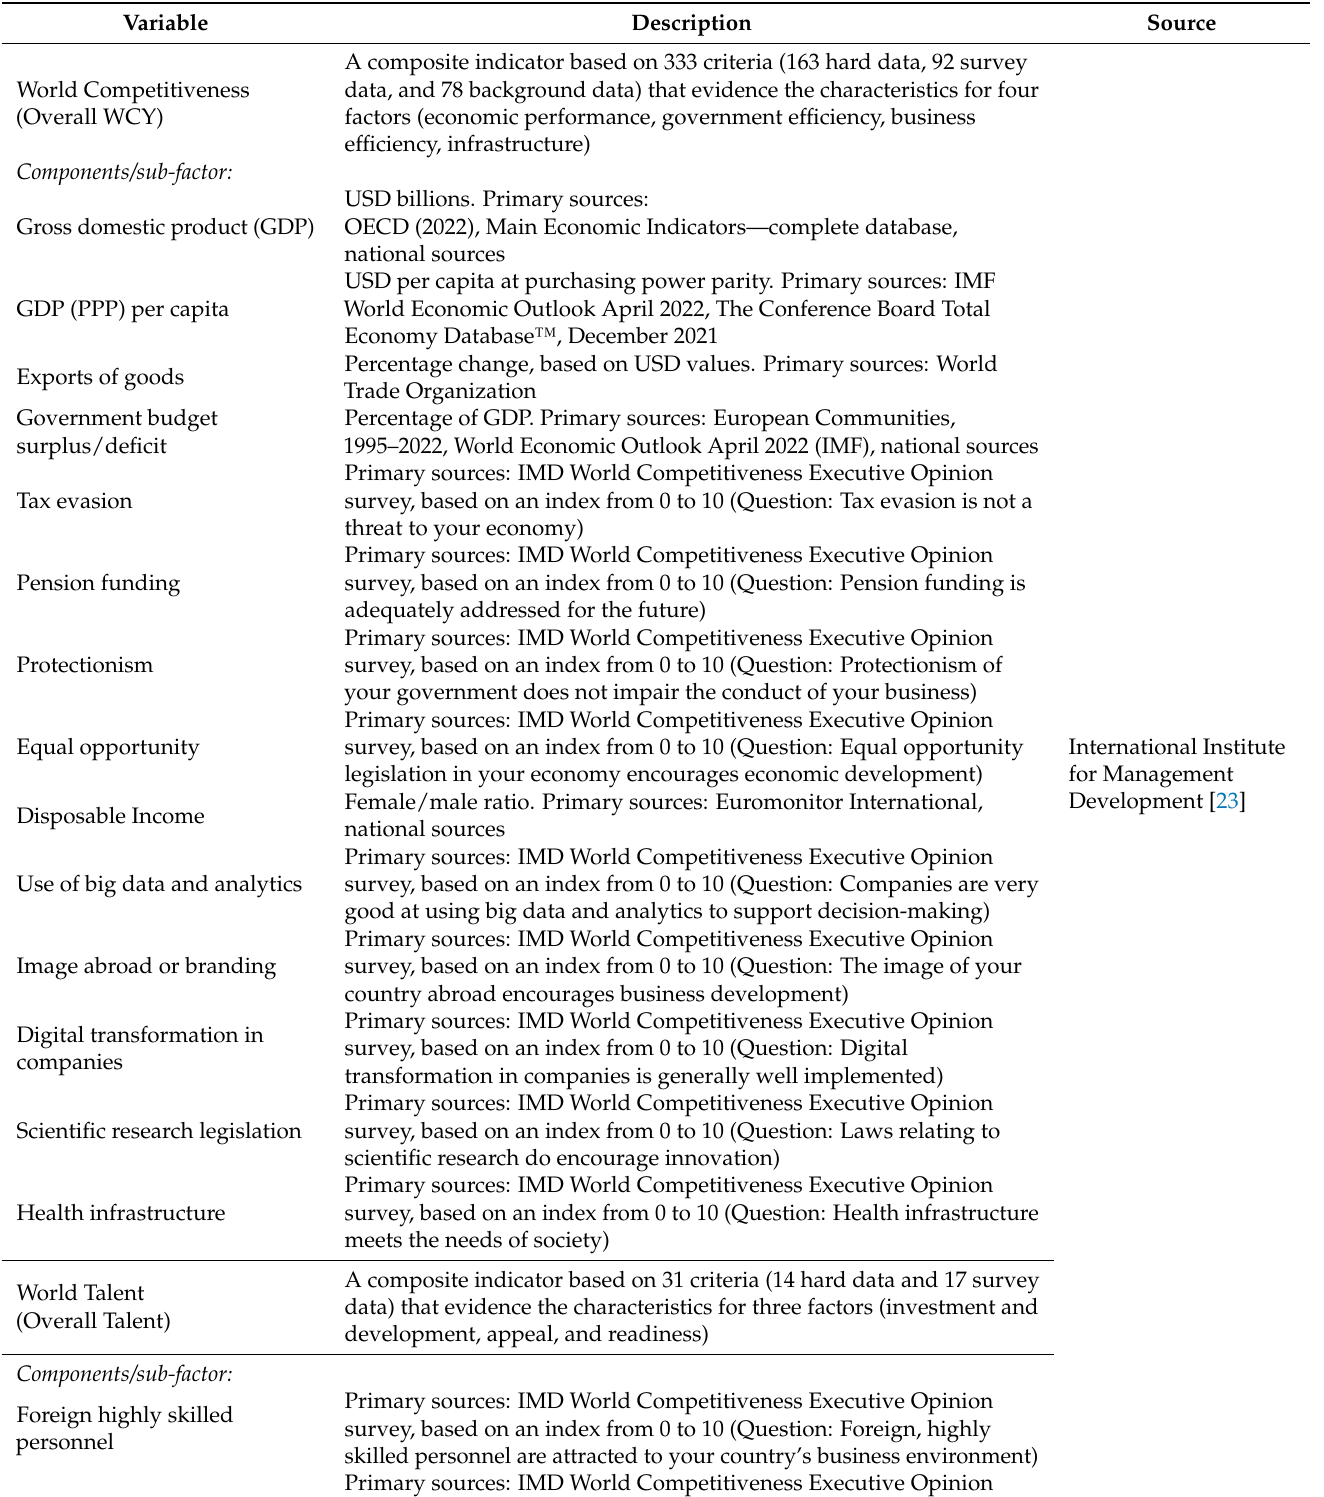
Table 2. Description of the used variables for